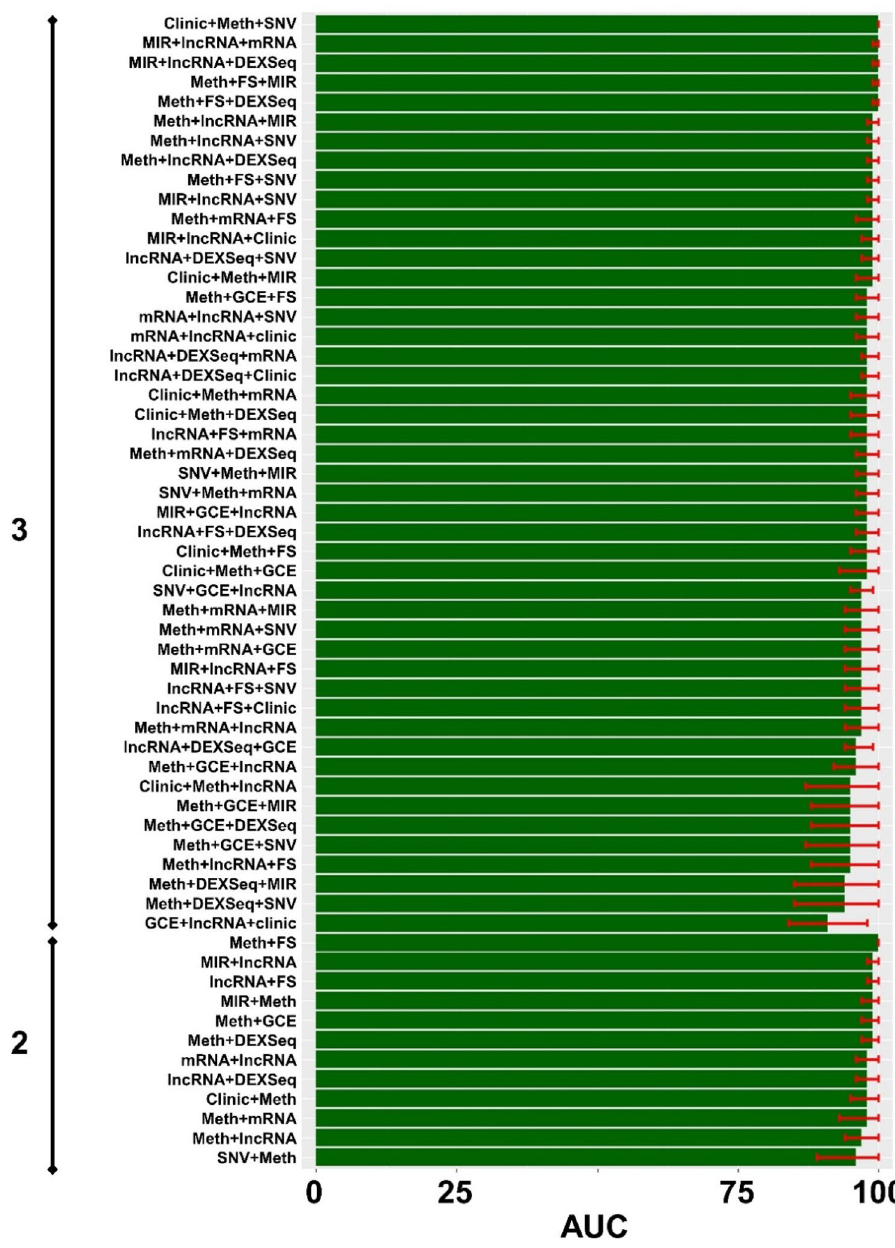
Figure 3. High performing prediction models of response. On the left is the number of types of data: 2 : combination of 2 types of data; 3 : combination of 3 types of data. Different performances are displayed in ascending order. The x axis is AUC as a percentage (0–100%). Although we tested 107 models with 1, 2 and 3 variables, we only represented those models with performances over 90% measured in AUC, N = 59 (to see all of them see Supplementary Figure S7). FS: Fusion genes; Meth: DNA methylation; SNV: single nucleotide variation; GCE: gene copy estimation; DEXSeq: exon expression; lncRNA: long non-coding RNA; MIR: micro RNA, mRNA: gene expression. Graphics were generated with R package ggplot (R version 3.6.3. http://www.r- proje ct.org) 69